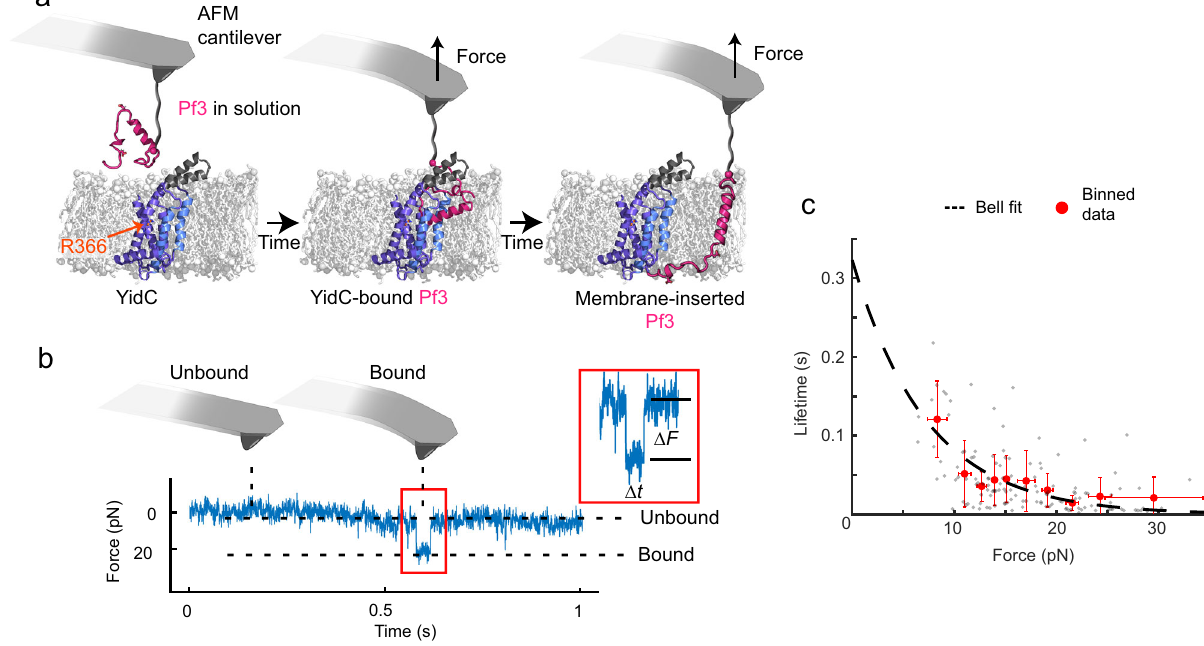
Fig. 1 Spontaneous binding events of single Pf3 to wild-type (wt) YidC reveal life time and transition state. a Schematic setup to detect interactions of YidC with Pf3 using AFM-based SMFS. Using AFM in the height clamp mode, the Pf3 polypeptide, which C-terminal end has been covalently tethered to the tip of the AFM cantilever (Supplementary Fig. 2), is kept in close proximity of ≈ 5 – 10 nm to a YidC containing membrane. If Pf3 (red) binds to YidC and/ or inserts into the membrane the PEG 27 -linker tethering Pf3 to the tip stretches and the cantilever bends, thus detecting an interaction force. Highlighted structural regions of YidC are R366 (orange arrow), TMH3 and TMH5 (blue), and cytoplasmic α -helical hairpin (grey). b Example of a FT curve detecting a binding event of Pf3 to YidC. The force ( Δ F ) and time ( Δ t ) of single binding events (inset) is extracted for analysis. c Analyzing the lifetime of single YidC- Pf3 binding events. Grey dots show individual data points ( n = 134, where n represents the number of binding events quanti fi ed) which were binned (red data points) and fi tted with the Bell model 26 (black dashed line) to extract the lifetime of the bond in the absence of an external force (e.g., at thermal equilibrium) to be t 0 = 0.32 ± 0.25 s (±95% con fi dence interval (CI)) and the transition state x β = 0.57 ± 0.27 nm (±95% CI) of the bond, which describes the distance Pf3 has to be pulled to separate from YidC. Error bars represent sd, which are centered at the mean value for each bin. Source data are provided as a Source Data fi labeled Pf3 to the supported membranes and imaged the samples using a combined AFM and confocal microscopy setup (Supple- mentary Fig. 4). The merged AFM topographs and fl uorescence images showed that Pf3 accumulated in membranes containing YidC.